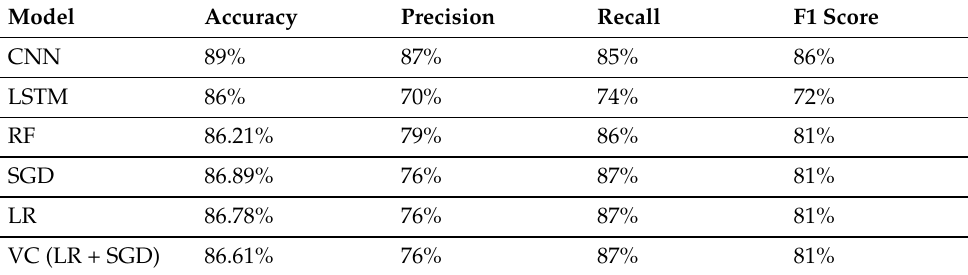
Table 3. Classification results of classifiers using fastText.